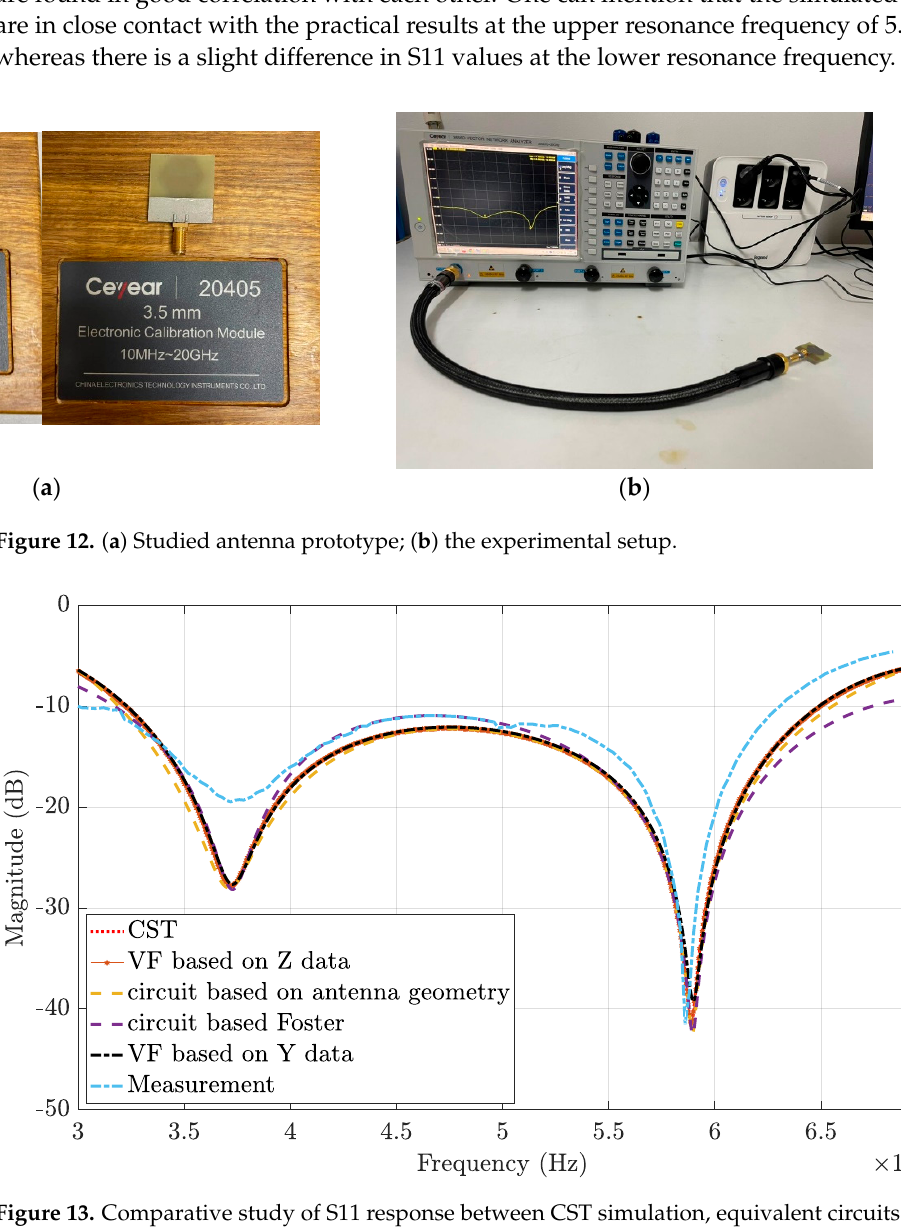
Figure 13. Comparative study of S11 response between CST simulation, equivalent circuits simula- tions, and measurement data.